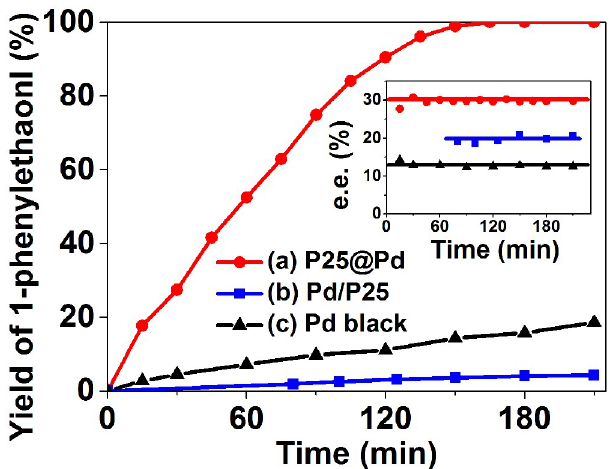
Figure 6. Catalytic results of acetophenone enantioselective hydrogenation over ( a ) P25@Pd, ( b ) Pd / P25, and ( c ) Pd black catalysts. Reaction conditions: 273 K, 7 mg of catalyst, 20 µ L of acetophenone, 400 mg of S-proline, 17 mL of methanol, and H 2 (60 mL·min −1 ). Table 1. Catalytic performance of P25@Pd, Pd / P25 and Pd black catalysts in the enantioselective hydrogenation of acetophenone.